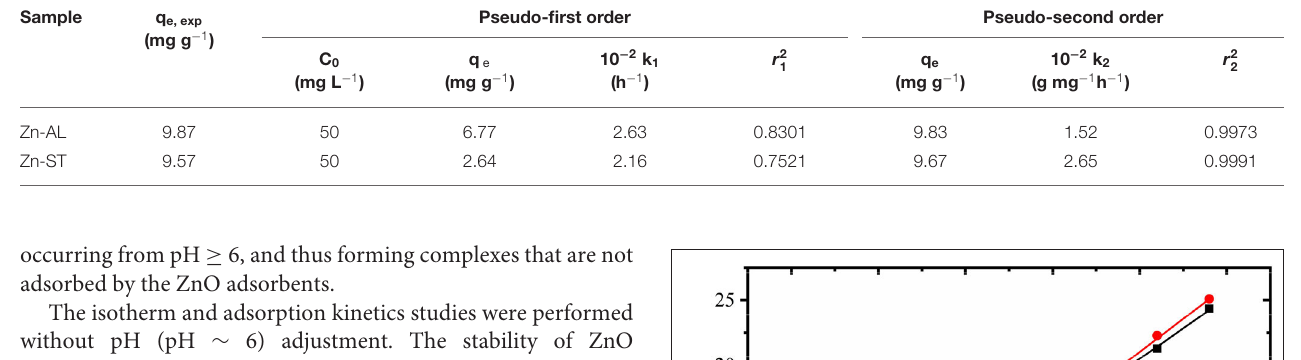
TABLE 3 | Kinetic parameters for Cu (II) removal using Zn-AL and Zn-ST as adsorbent. Sample